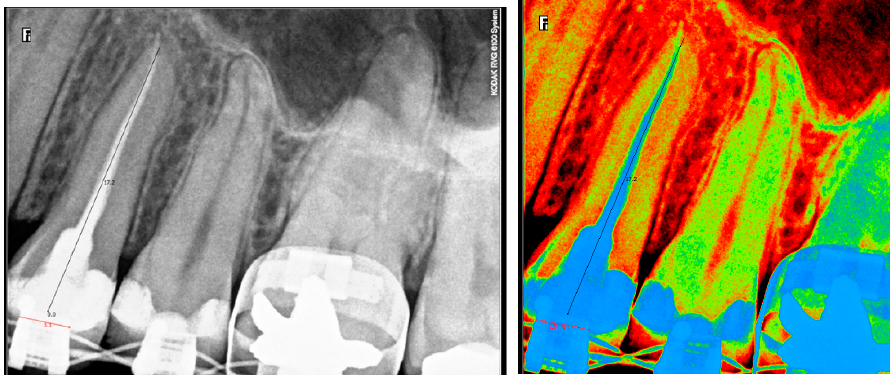
Figure 4. Digital measurement of radiological length using IPRs.